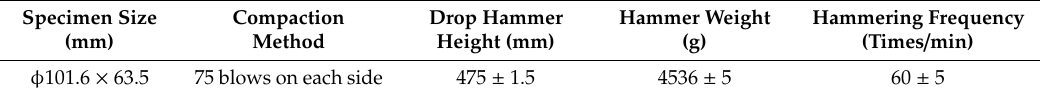
Table 7. Working parameters of a Marshall electric compactor.